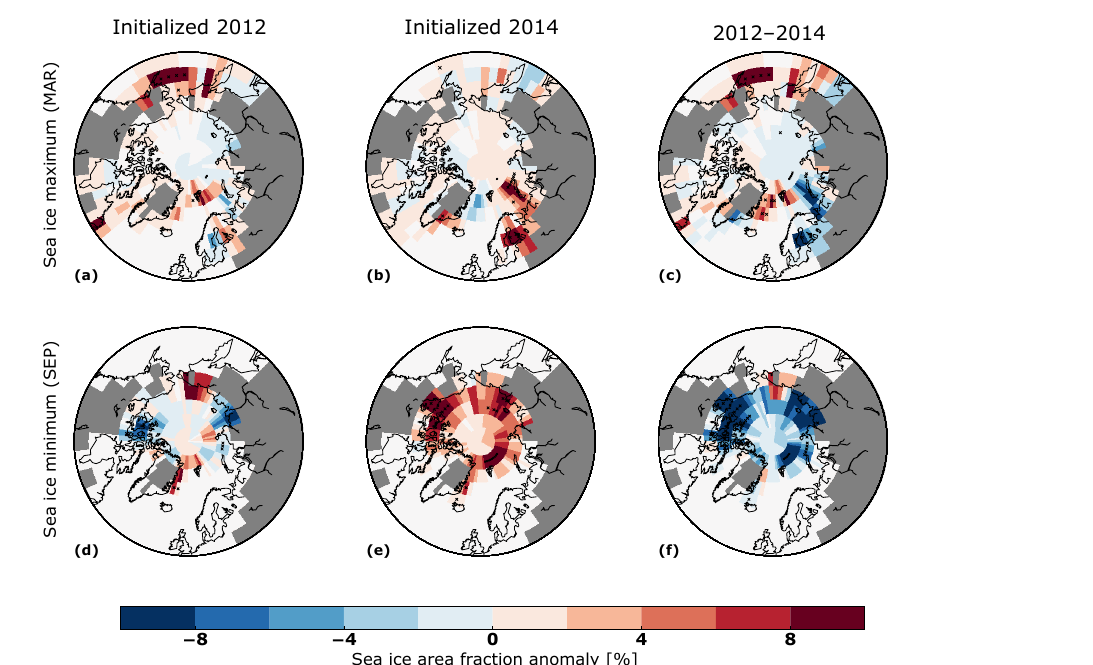
Figure 5. Differences in ensemble mean forecasts of SIC for prediction years 1–4, (a–c) for the 4-year mean maximum in March, and (d–f) for the 4-year mean minimum in September. (a, d) Exp-2012 (Pinatubo-2012 – b1-2012), (b, e) exp-2014 (Pinatubo-2014 – b1-2014), and (c, f) the difference between the two (exp-2012 – exp-2014). Crosses denote values significantly different from zero exceeding a 5% level.